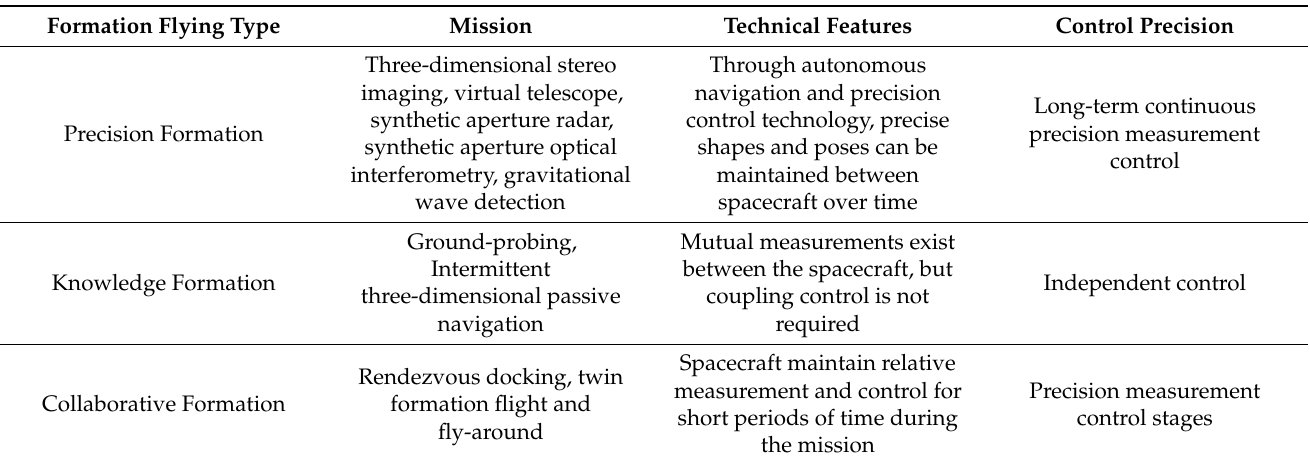
Table 1. Example of spacecraft formation flying.